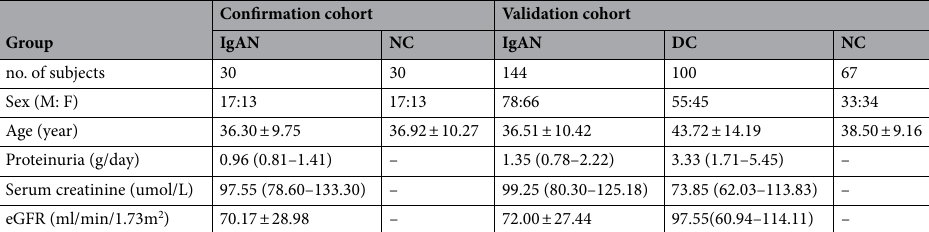
Table 3. Baseline demographic and clinical characteristics of patient groups. IgAN, IgA nephropathy; DC, Disease control; NC, Normal control; GFR, Estimated glomerular filtration rate.